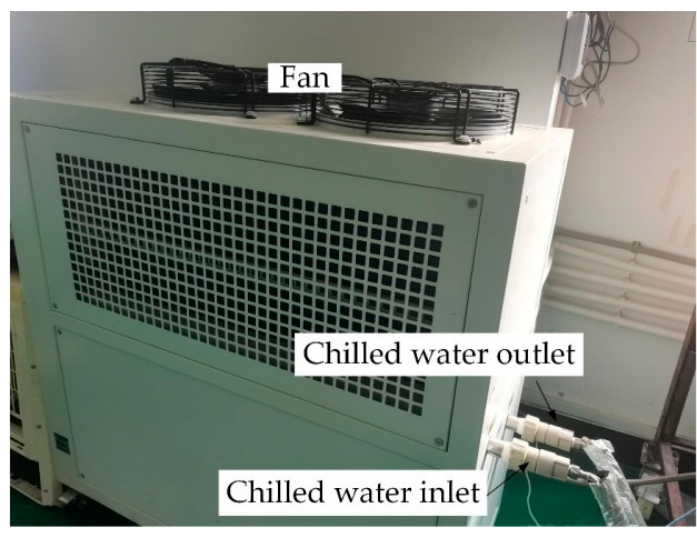
Figure 7. Cooling water system.